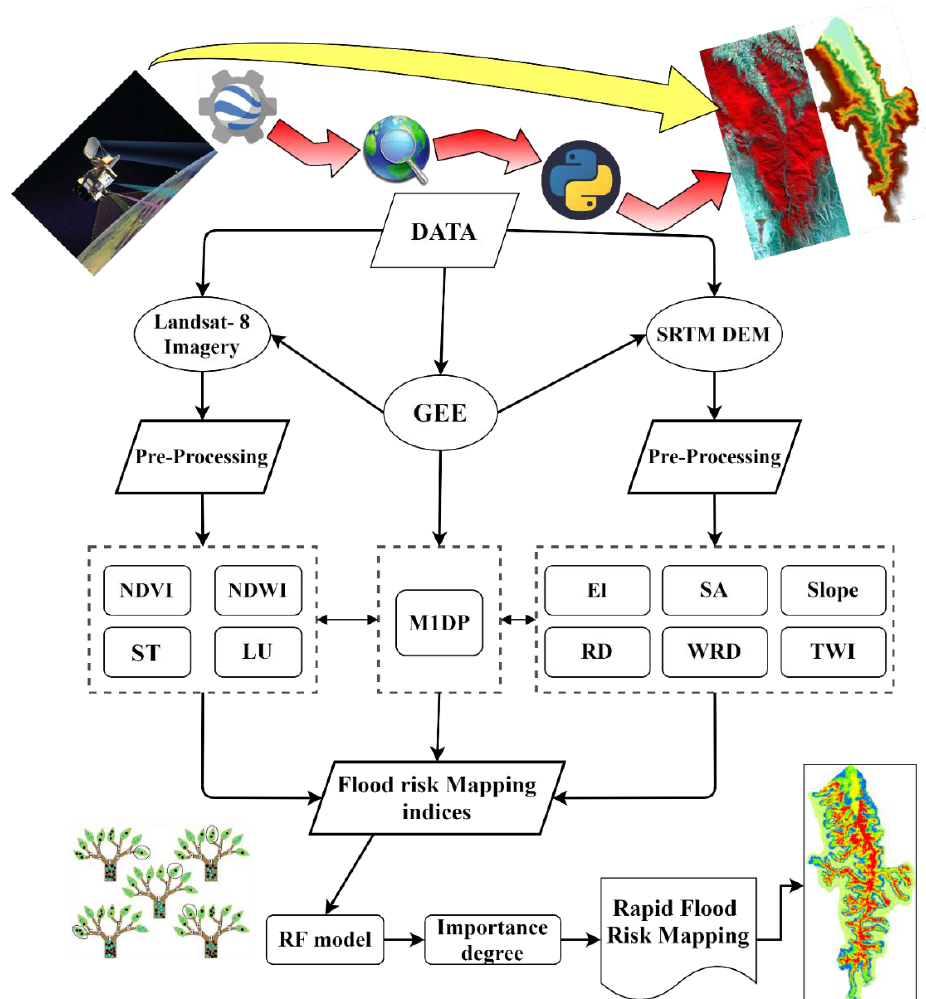
Figure 2. Schematic diagram of rapid flood risk mapping.